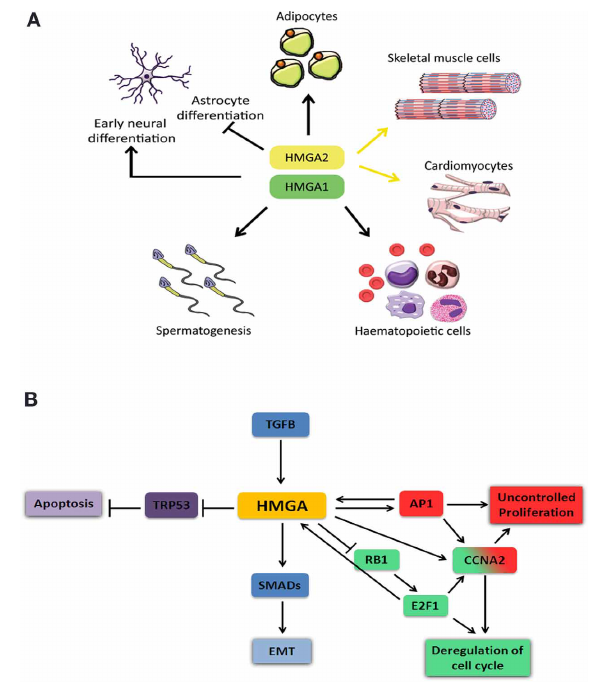
FIGURE 2 | Schematic representation of HMGA role during cell differentiation and cancer. (A) HMGA proteins are required for proper development and progenitor cell differentiation to adipocyte, skeletal muscle, cardiac muscle, spermatozoids, and hematopoietic cells. They have a dual role in neuronal differentiation, where they are required during early neural progenitor differentiation but inhibit astrocyte differentiation at later stages. (B) HMGA proteins are involved in cellular processes that induce tumor formation and metastasis. Abnormal high expression of HMGA proteins results in tumor formation and metastasis. HMGA proteins deregulate cell cycle and thereby increase cell proliferation through either inhibition of RB1 and induction of E2F1 (green) or activation of AP1 and increased Cyclin A2 ( Ccna2 ) expression (red). HMGA interaction with TRP53 blocks its activity and results in inhibition of apoptosis (purple). TGFB positively regulates HMGA expression (blue). HMGA interaction with SMADs leads to epithelial mesenchymal transition